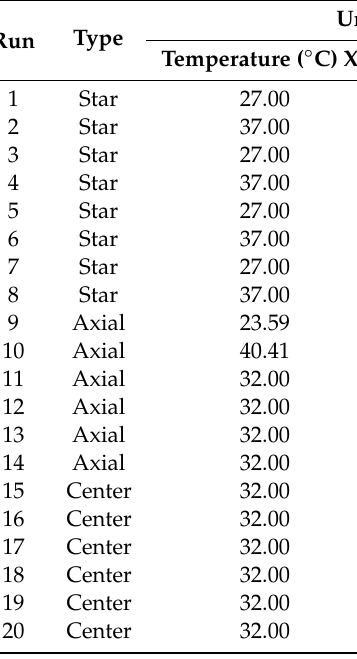
Table 2. The CCD experimental schemes and